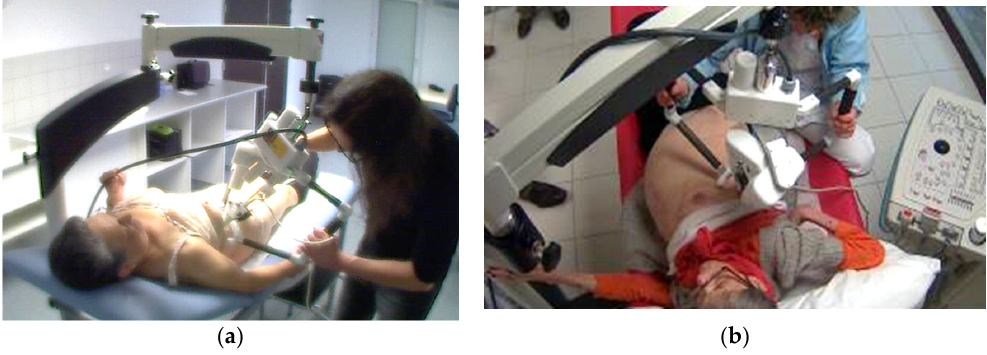
Figure 1. ( a ) Robotic arm (RA) suspended from its ground support and ( b ) located above a patient.